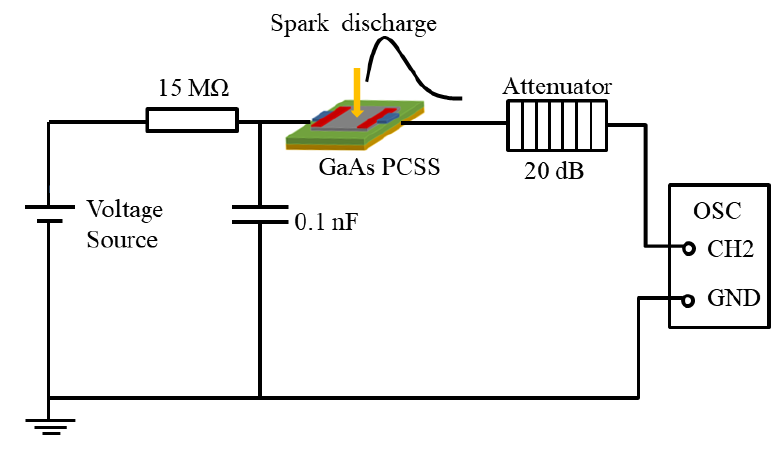
Figure 2. Experiment test circuit for a lateral GaAs PCSS charged by a 0.1 nF capacitor.